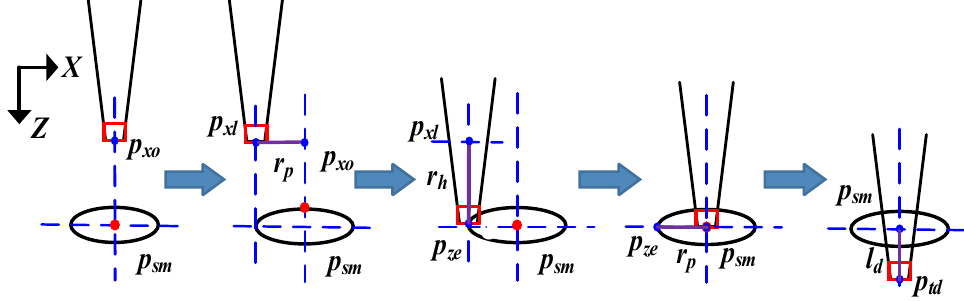
Figure 5. Insertion depth control